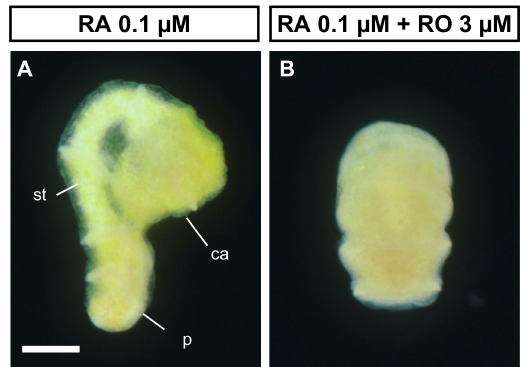
Figure 5. RO treatment suppressed the induction of metamorphosis by RA. RA 0.1 µ M treatment with doliolaria larvae induced the metamorphosis ( A ), while this induction was suppressed by adding RO 3 µ M ( B ). ca; calyx, st; stalk and p; adhesive plate. Scale bar: 125 µ